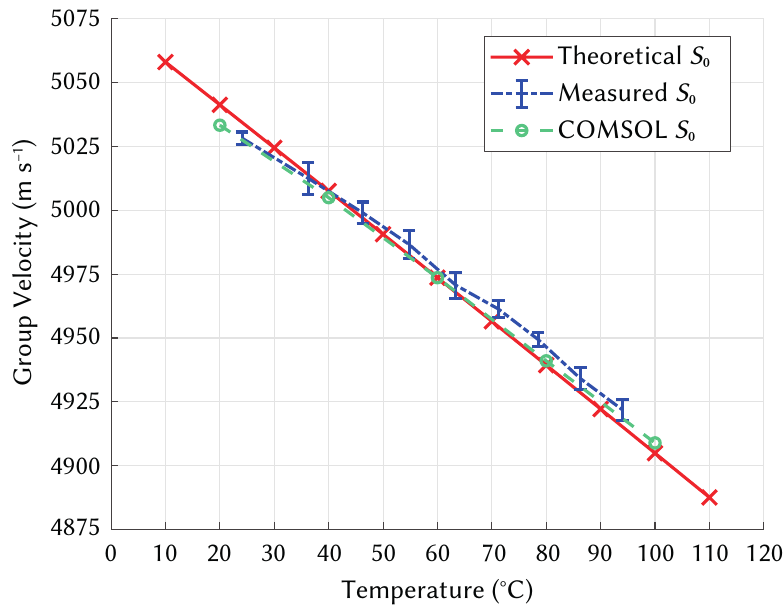
Figure 10. Velocity change with temperature for S 0 Lamb wave mode in Aluminium. Comparison between theoretical, experimental, and simulated